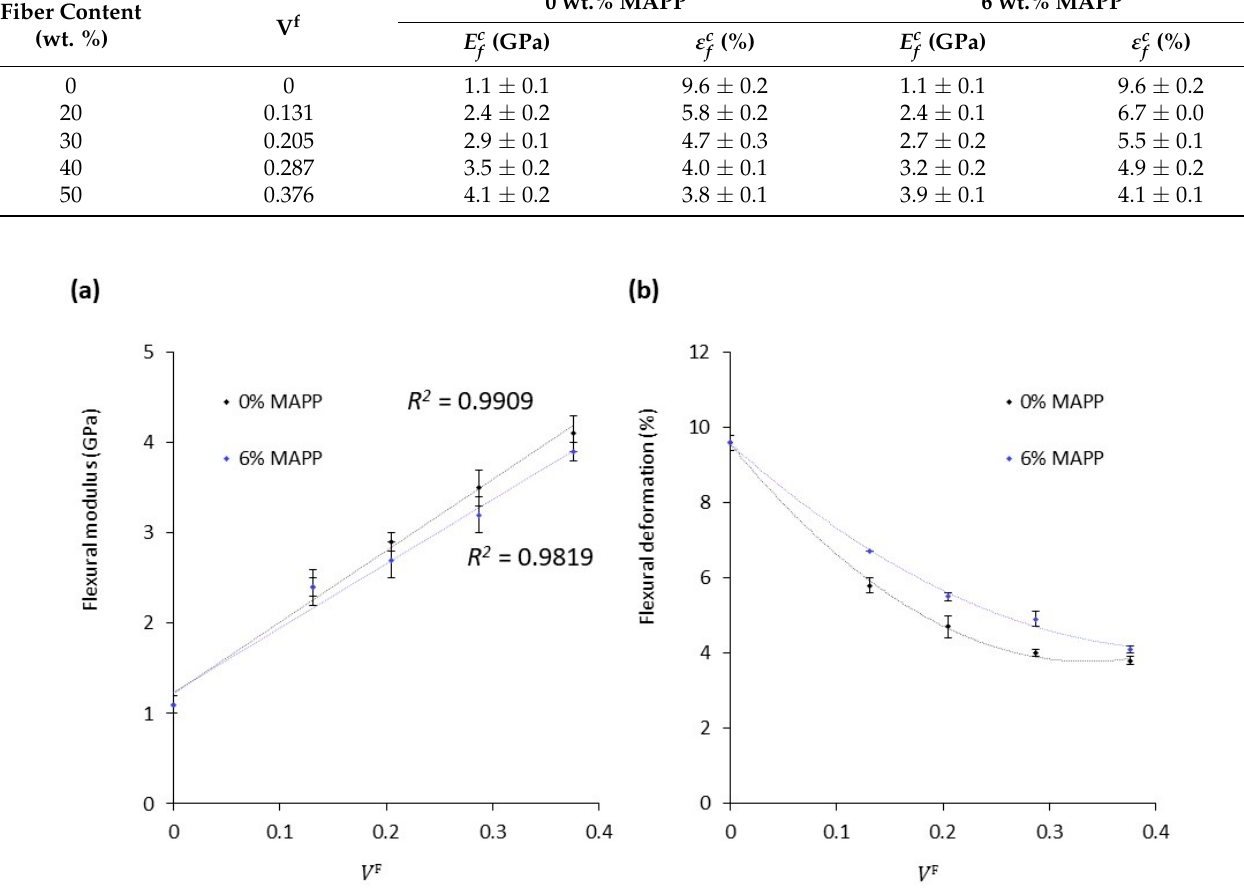
Figure 2. Evolution of the ( a ) flexural modulus and ( b ) flexural deformation with the fiber volume fraction of the composites against reinforcement volume fraction.